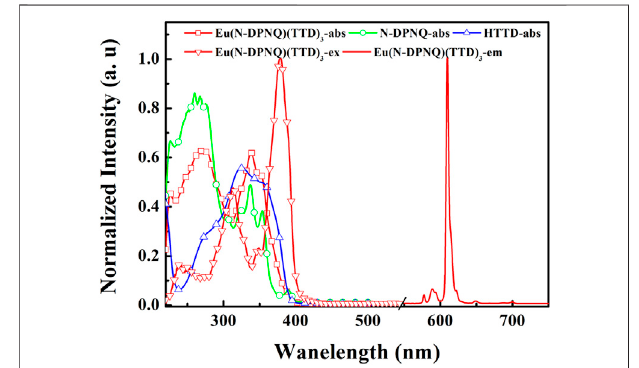
FIGURE 2 | Absorption, excitation, and PL spectra of Eu (N-DPNQ) (TTD) 3 , N-DPNQ and HTTD in